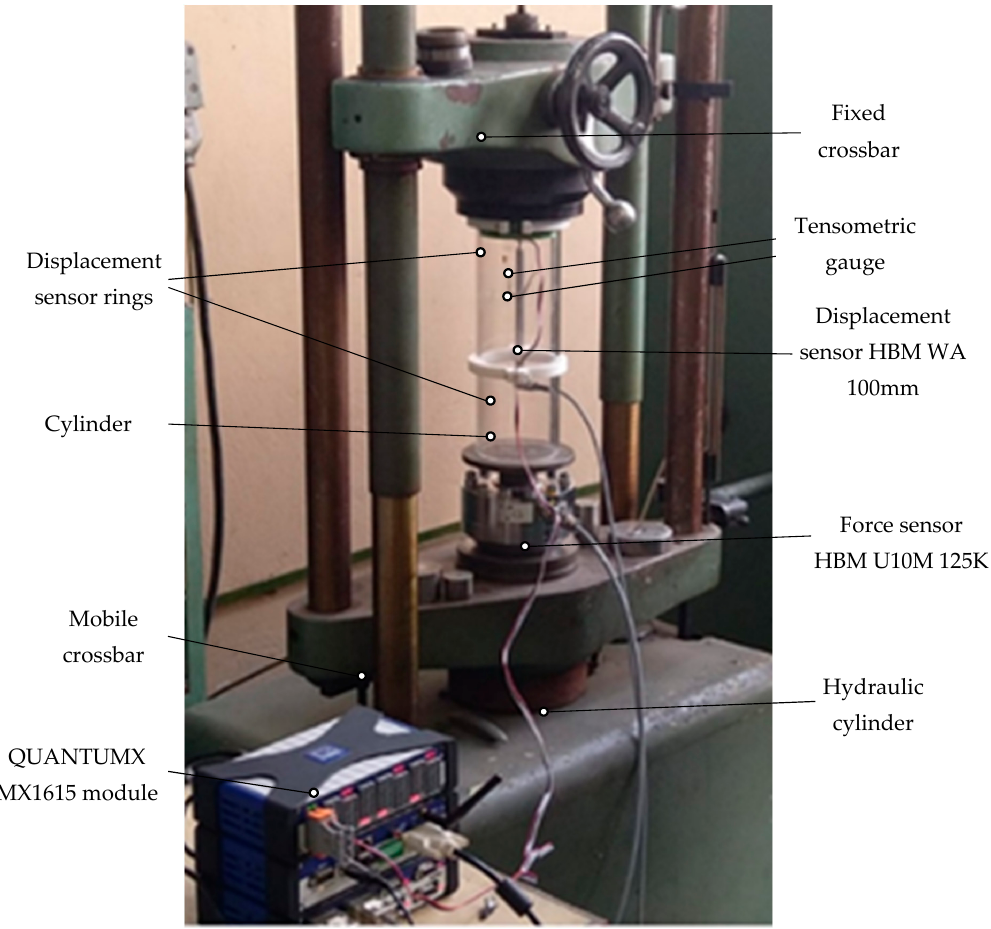
Figure 7. Cylinder positioned over the force sensor.